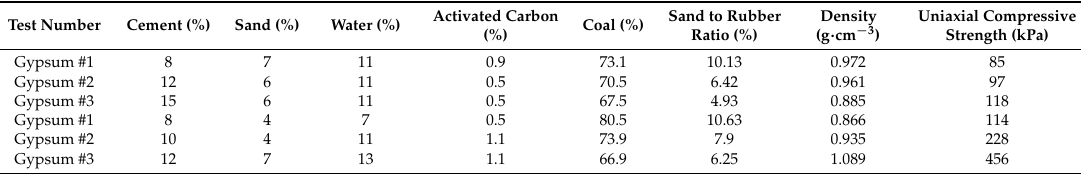
Table 1. Optimum test results of cement.